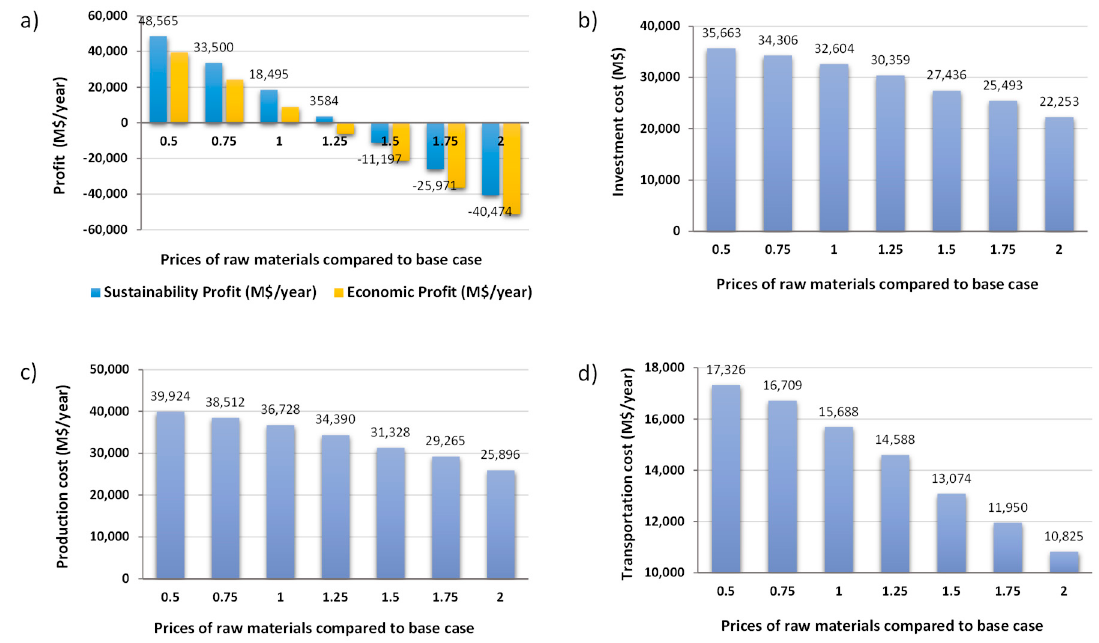
Figure 9. Influence of costs of raw materials on different objectives: ( a ) sustainability and economic profit, ( b ) investment cost, ( c ) production cost, and ( d ) transportation cost.